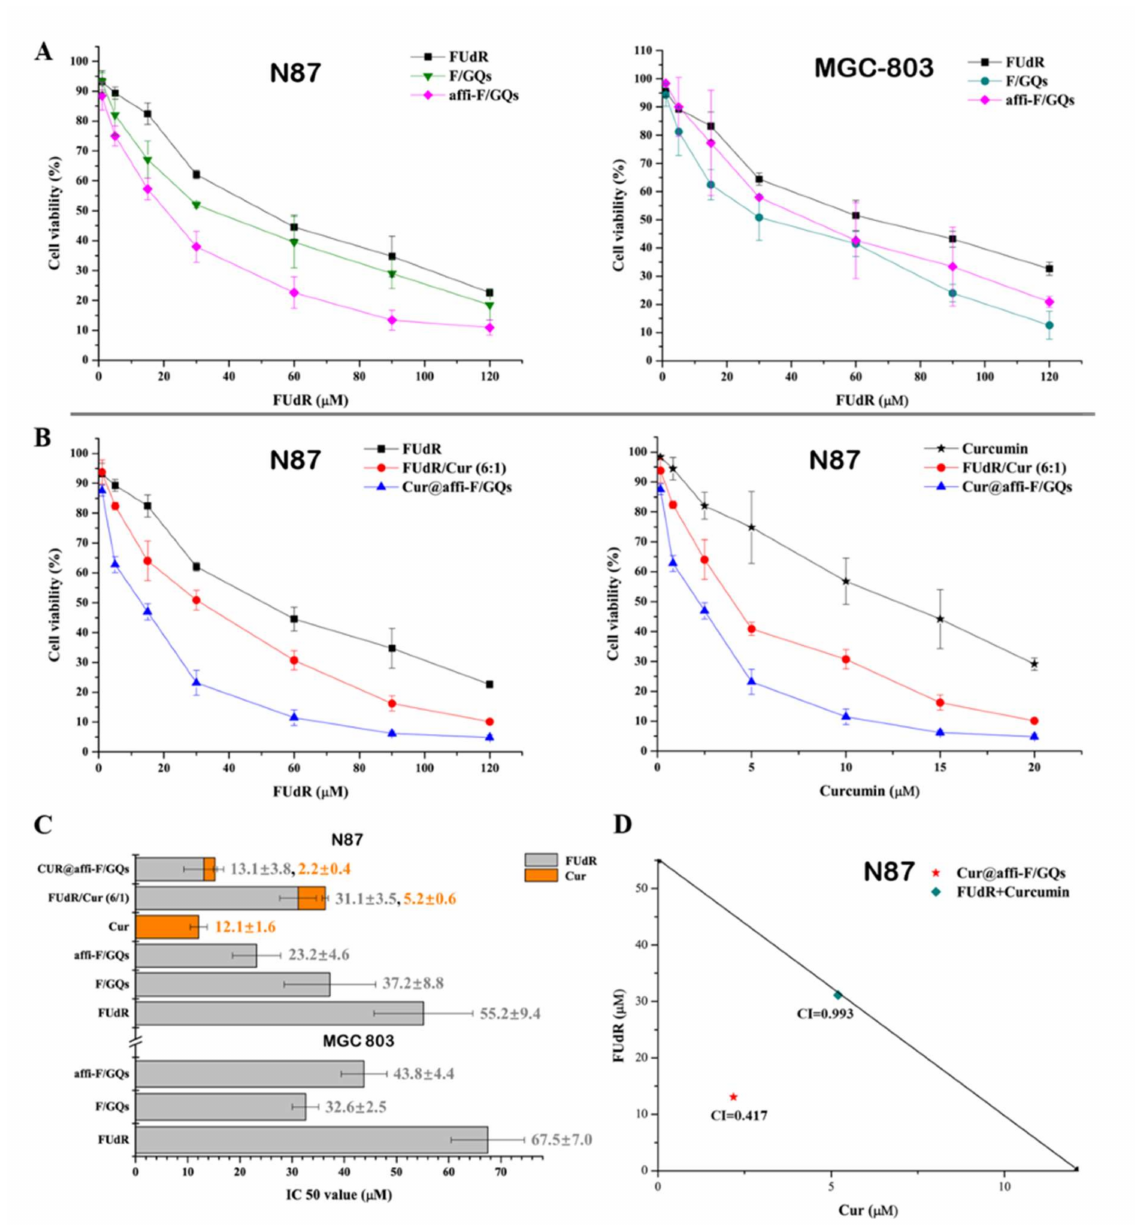
Figure 7. ( A ) In vitro cytotoxicity of free FUdR, F/GQs and affi-F/GQs after 48 h of co-incubation in N87 and MGC 803 cells, respectively. ( B ) Cytotoxicity test of N87 cells treated with FUdR and Cur alone, FUdR/Cur (6:1) (a physical mixture of FUdR and Cur at a molar ratio of 6:1) and Cur@affi- F/GQs (the same ratio of FUdR/Cur) for 48 h, respectively. ( C ) IC50 values of FUdR and Cur in gastric cancer N87 and MGC 803 cells. ( D ) Synergetic effect analysis of FUdR/Cur (6:1) and Cur@affi-F/GQs in N87